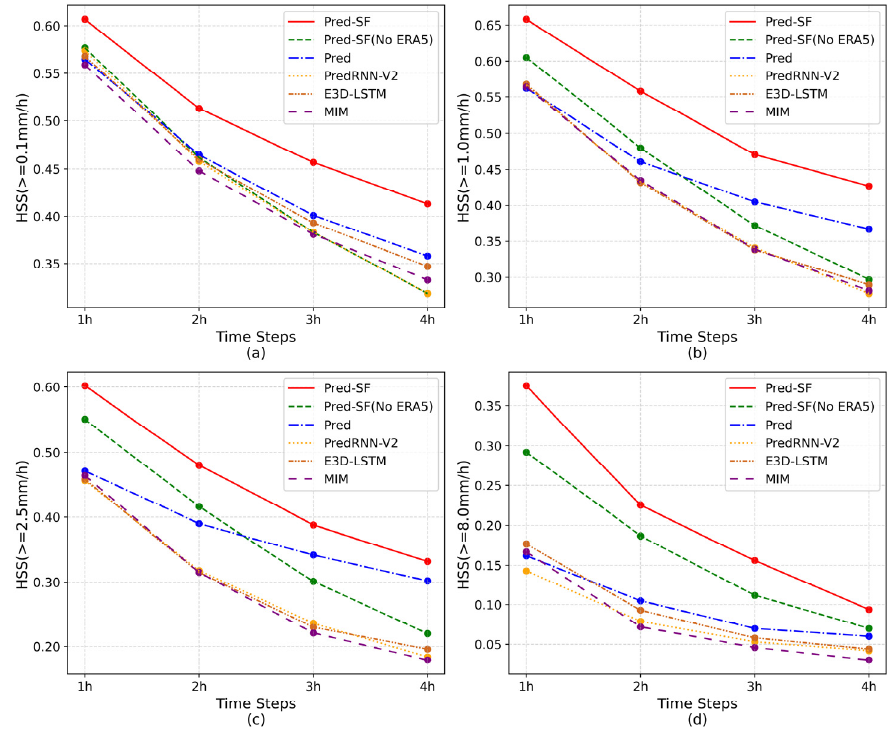
Figure 6. HSS index of the six groups of models at each prediction moment: ( a ) precipitation is greater than 0.1 mm/h; ( b ) precipitation is greater than 1.0 mm/h; ( c ) precipitation is greater than 2.5 mm/h; ( d ) precipitation is greater than 8.0 mm/h.